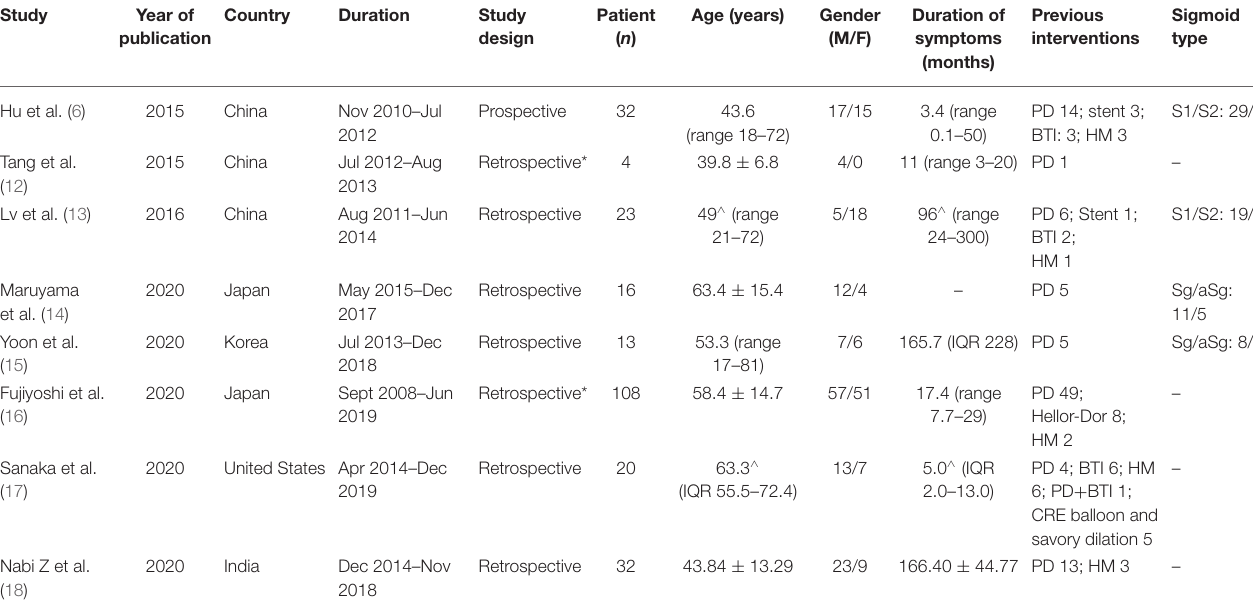
TABLE 1 | The baseline characteristics of included